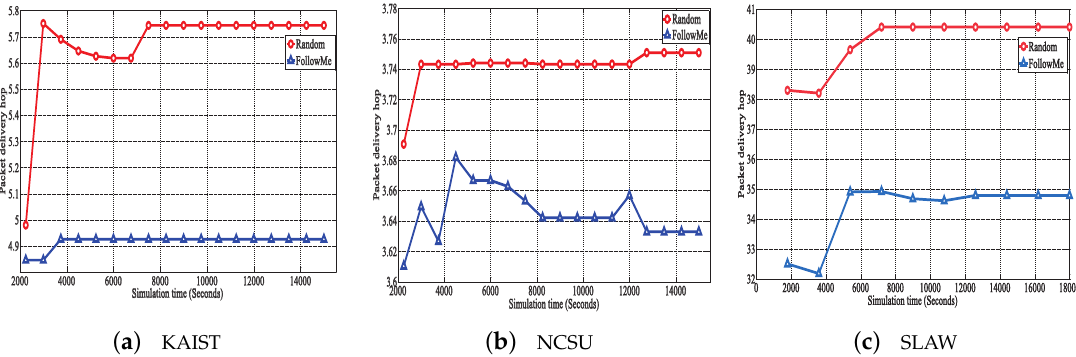
Figure 5. The number of hops of FollowME and Random within PRoPHET under three